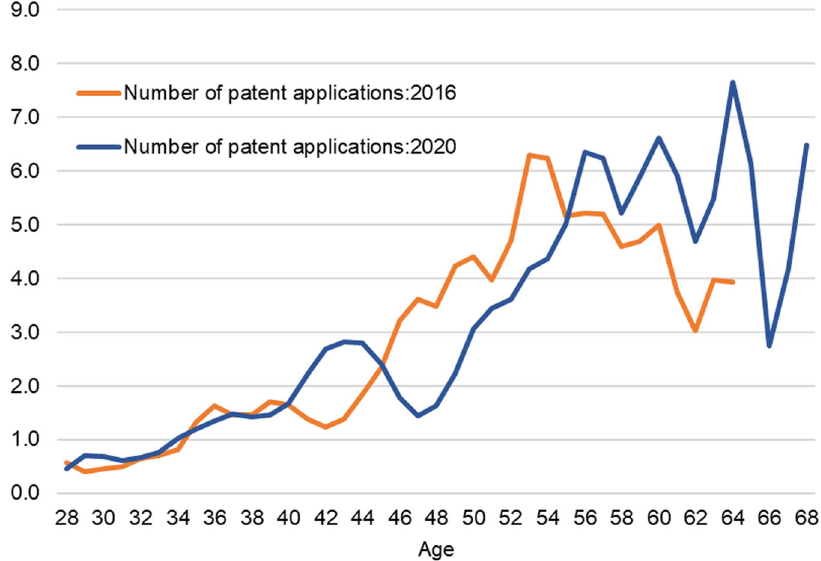
Fig. 4 Trends in the number of patent applications by age: 2016 and 2020 survey data. The graph plots the average values of the number of patent applications by age (3-year moving average, which is the average of data for 3 years: the preceding year, the represented year and the following year).